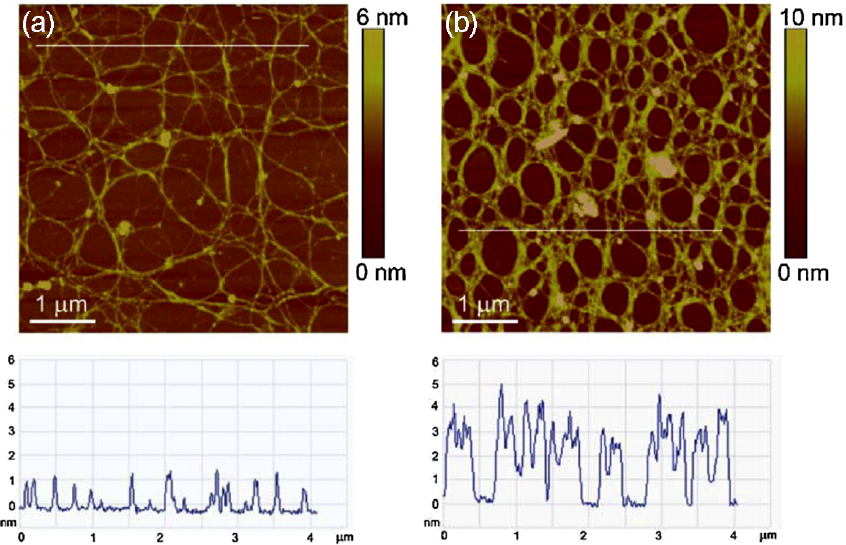
Figure 6. AFM topographic images of marine gel representing networks with (a) a low degree of fibril cross-linking and (b) a high degree of cross-linking with the corresponding cross sections along the indicated lines. Marine gel samples were collected in the northern Adriatic (SJ 105) in 23 June 2003, at a depth of 10–13m (Miši´c Radi´c et al.,